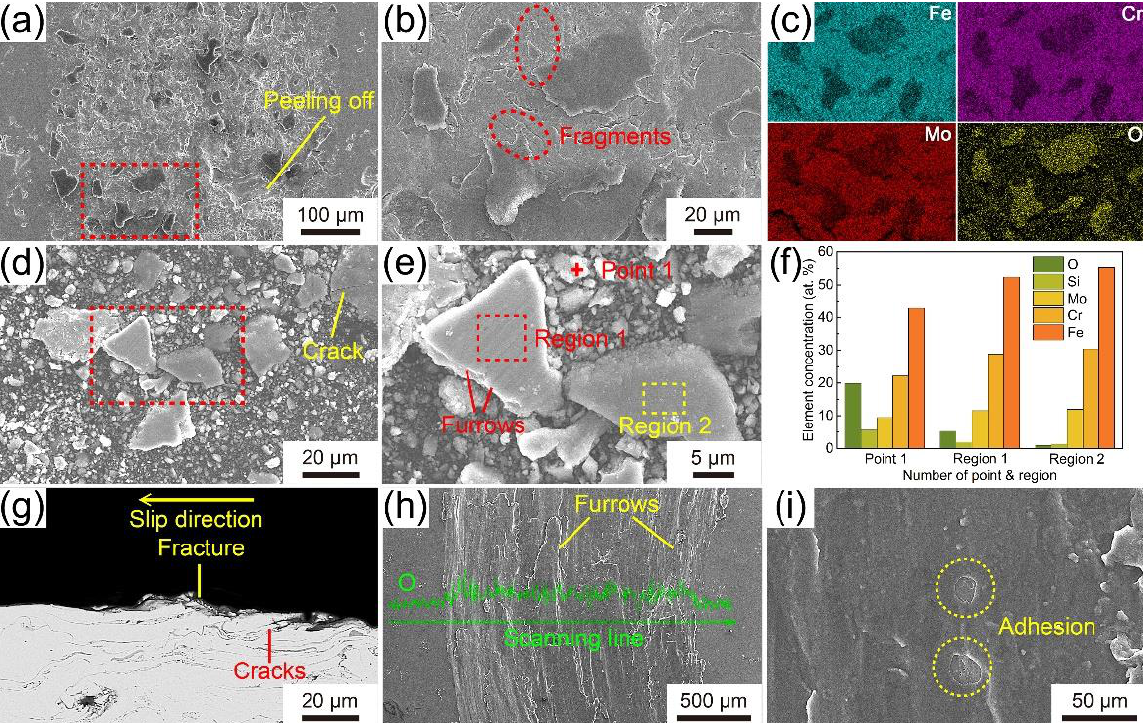
Figure 11. SEM images with low ( a ) and high ( b ) magnification of the worn surfaces of Coating D after abrasion, ( c ) EDS mapping of the zone marked in ( a ); SEM images with low ( d ) and high ( e ) magnification of the wear debris of Coating D; ( f ) element concentration of Point 1, Region 1 and Region 2 in ( e ); ( g ) SEM image of the cross section of Coating D after abrasion; SEM images with low ( h ) and high ( i ) magnification of worn surfaces of LA141 magnesium alloy; insets of ( h ) are the EDS line-scanning pattern of O element along the marked direction.